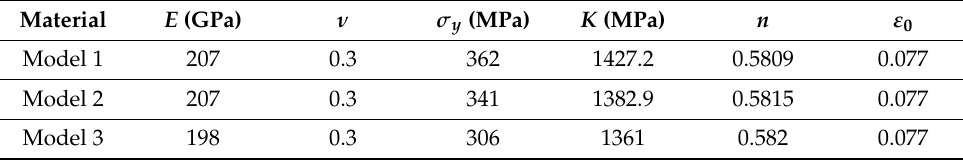
Table 4. Mechanical properties and material parameters of SUS304 stainless steel.